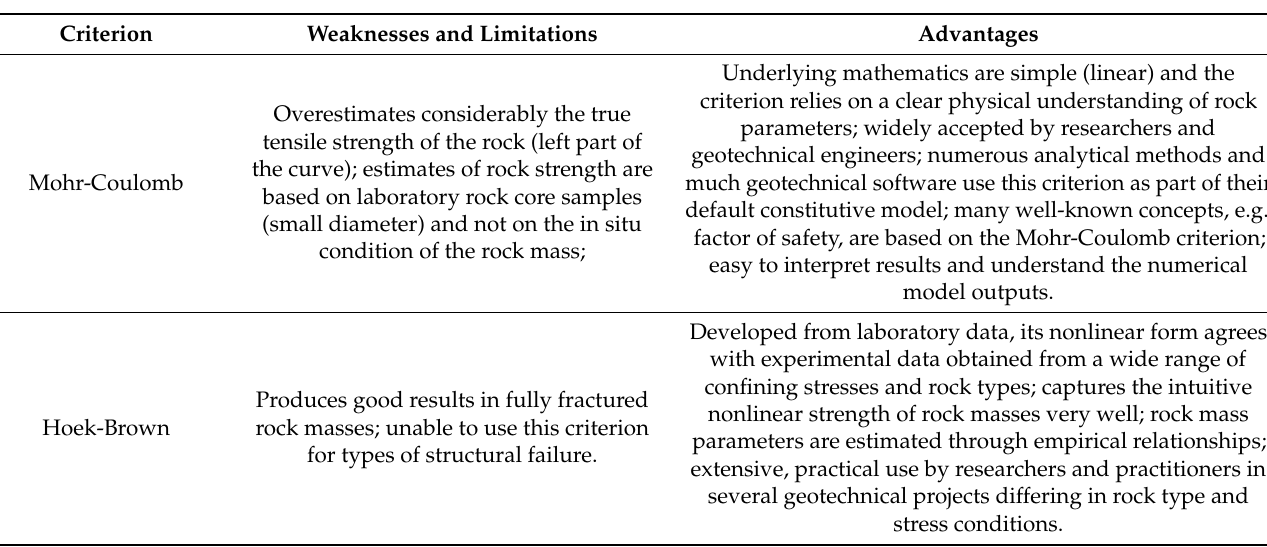
Table 1. The limitations and advantages of equivalent Mohr-Coulomb and generalized Hoek- Brown